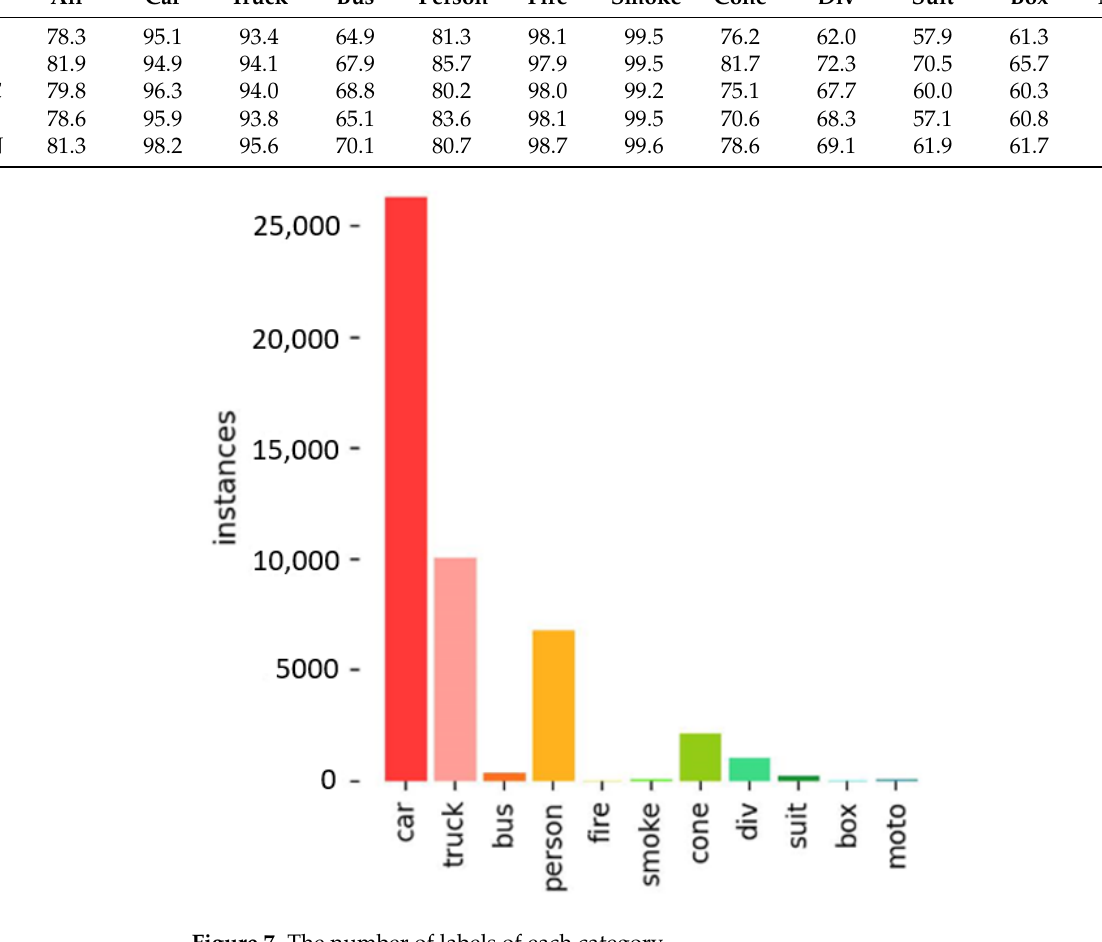
Figure 7. The number of labels of each